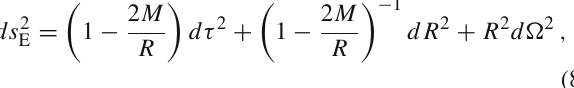
Fig. 3 A constant t hypersurface will be analytically continued to the Euclidean manifold. The past (lower) part has no scalar field and the future (upper) part has a non-trivial scalar field solution. As we magnify around the symmetric point (Einstein–Rosen bridge), we can approx- imate that any solution is a superposition of in-going and out-going modes. We can choose a condition that there are only out-going modes.